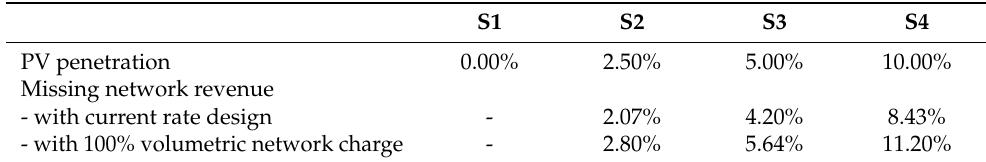
Table 4. Missing network revenue by PV penetration level under current rate design and 100% energy